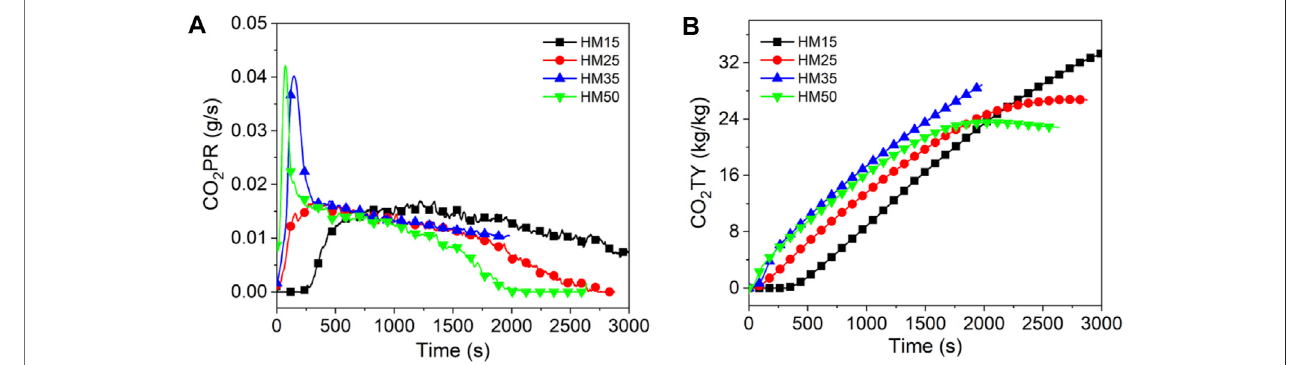
FIGURE 10 | Lignite curves: (A) PCO 2 PR, and (B) CO 2 TY.